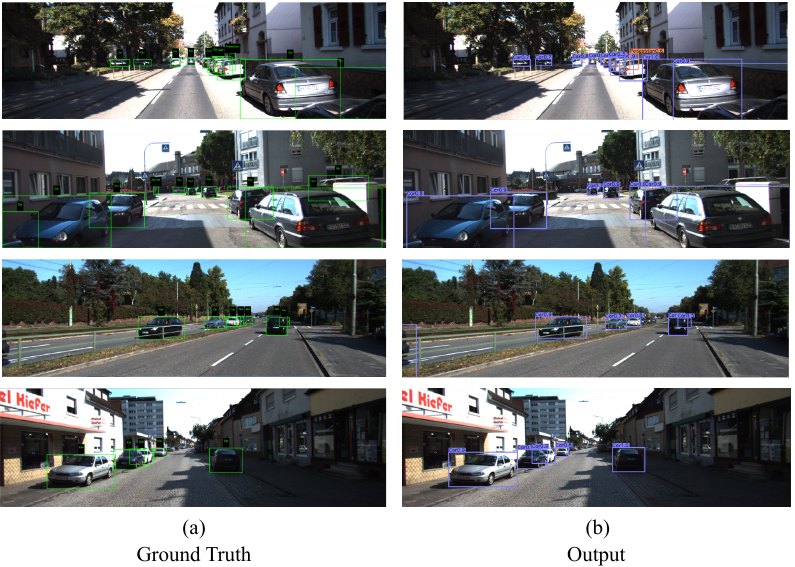
Figure 5. Visualization of 2D detection for cars in four scenes. In each picture group, we show the ground-truth ( a ) and the output ( b ).